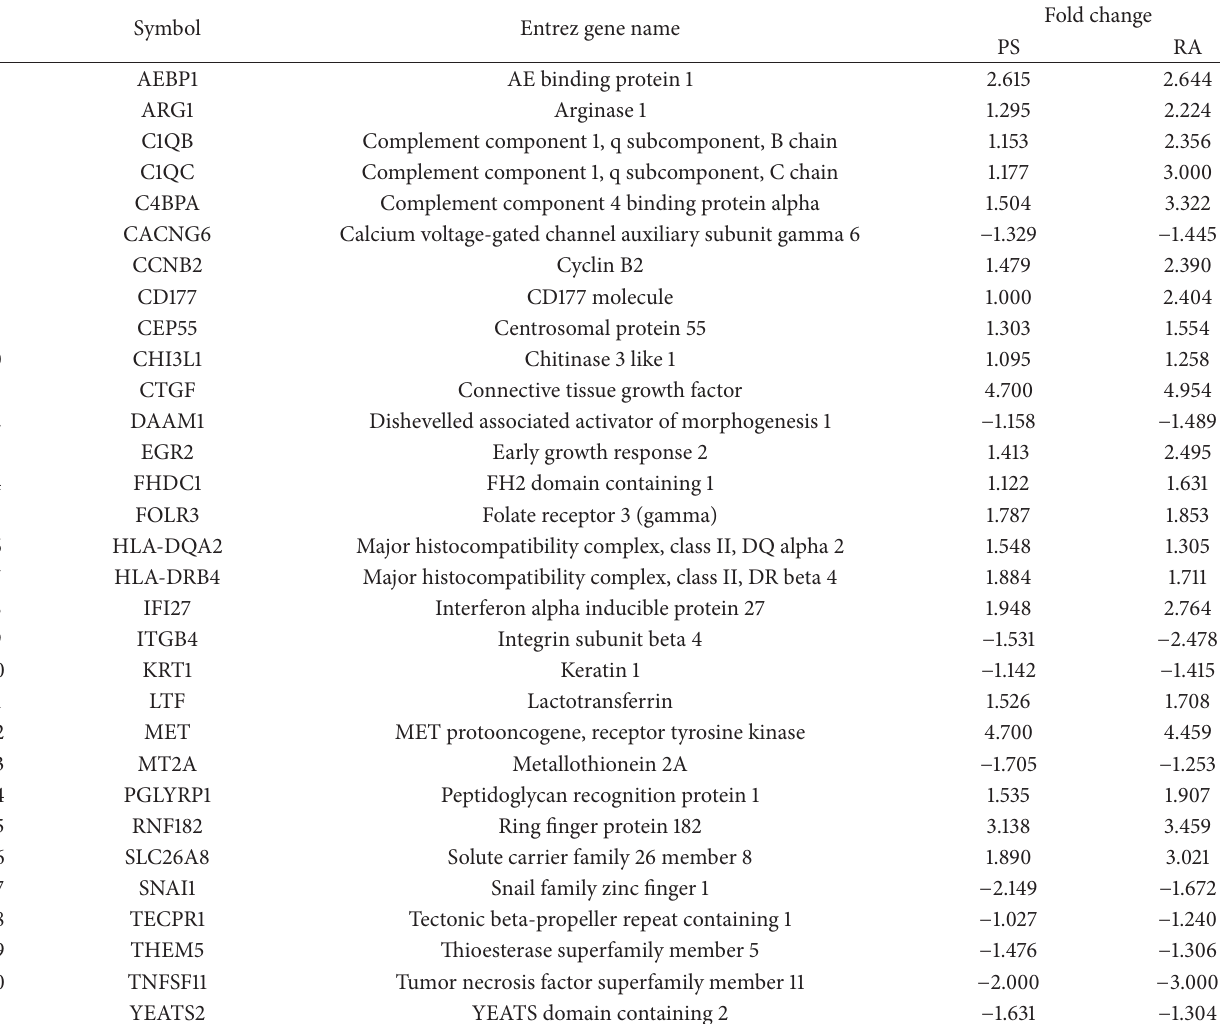
Table 2: The shared DEGs in PS and